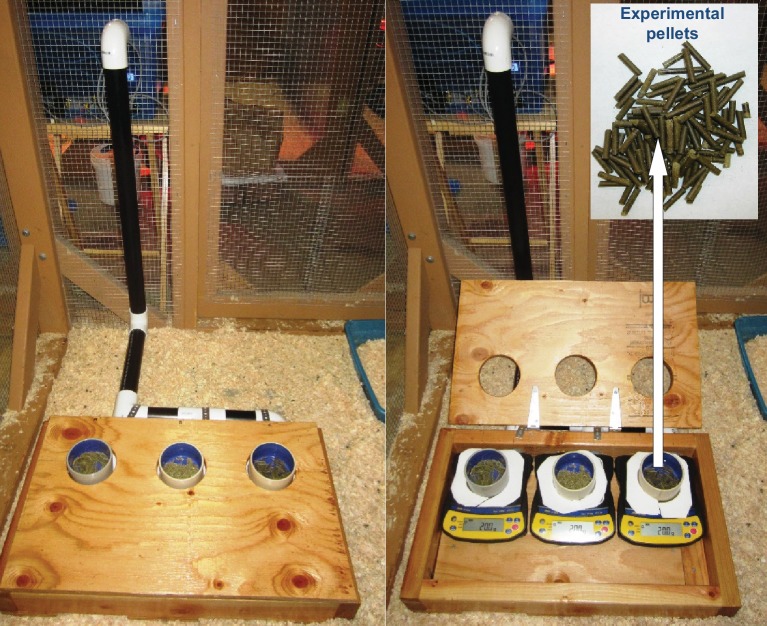
Experimental setup for feeding preference assays for cottontail rabbits (Sylvilagus nuttallii).